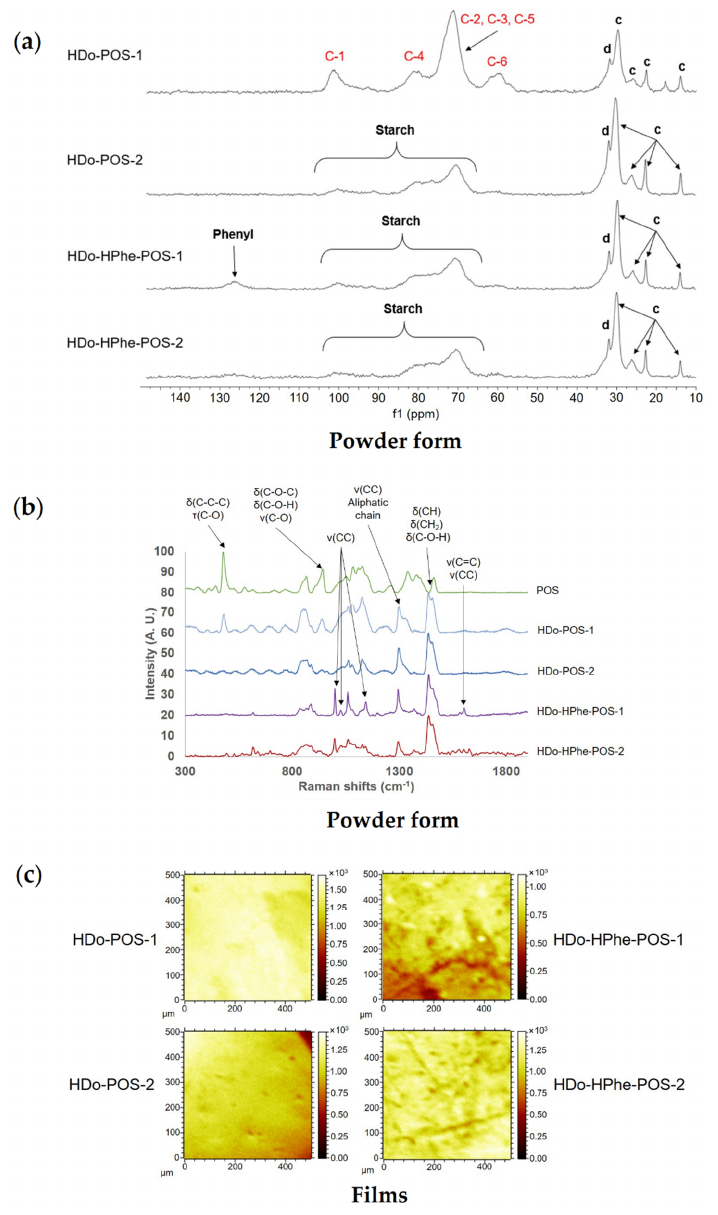
Figure 9. Bulk and surface characterization of ethers produced from potato starch. ( a ) Solid-state 13 C-NMR spectra obtained for HDo-POS-1, HDo-POS-2, HDo-HPhe-POS-1 and HDo-HPhe-POS-2 and their spectral decomposition, ( b ) Raman spectra of potato starch (POS) and corresponding ether starches (HDo-POS-1, HDo-POS-2, HDo-HPhe-POS-1 and HDo-HPhe-POS-2), ( c ) TOF-SIMS 2D mapping of POS ethers films. The DS of HDo-POS-1, HDo-POS-2, HDo-HPhe-POS-1 and HDo-HPhe-POS-2 were 0.40, 1.60, 1.45/0.10, and 1.67/0.19, respectively.